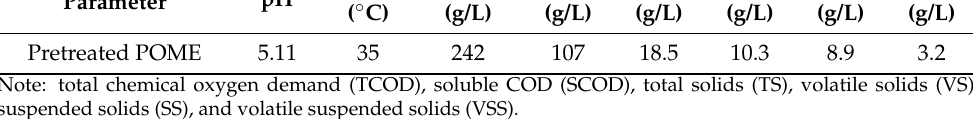
Table 1. Characteristics of palm oil mill effluent (POME) after pretreatment. Parameter pH